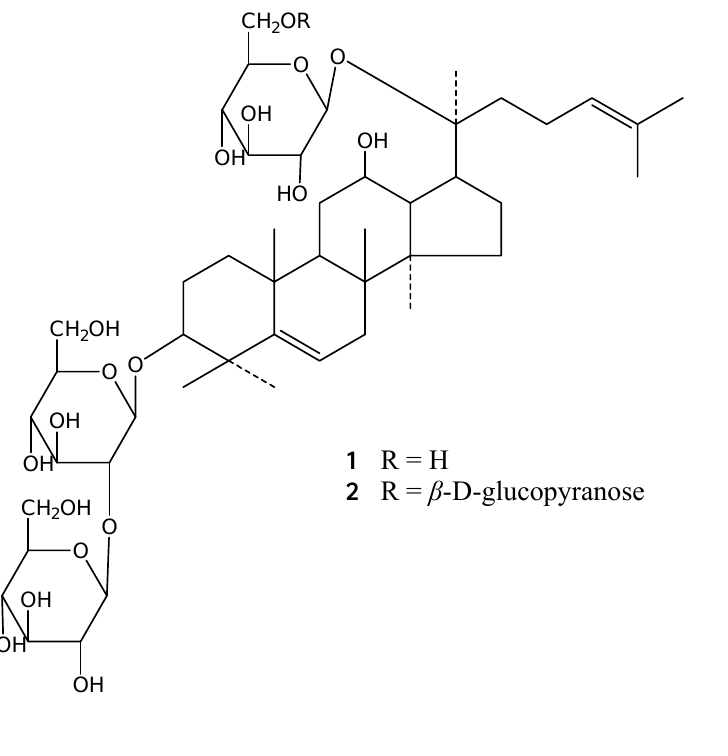
Figure 1. Structures of compounds 1 and 2